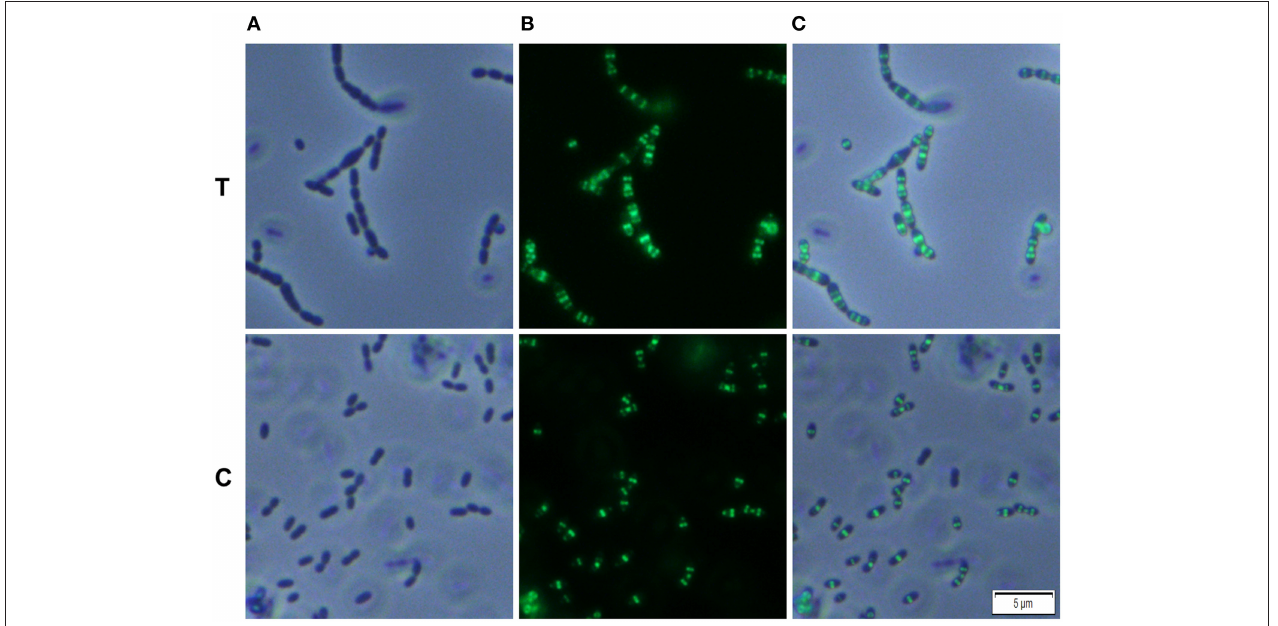
FIGURE 3 | Effect of Carolacton treatment on the localization of the cell division protein DivIVa in S. mutans UA159. The chromosomal GFP + -DivIVa reporter strain MR39 was grown in buffered (75 mM and pH 6.5) complex THBY medium to the early exponential growth phase (OD 600 = 0.2). Cells were treated with and without 5.3 µ M Carolacton and GFP + -DivIV expression was induced for all samples (treated/untreated) with 1.5% D-xylose. 3 h post induction cells were harvested, washed and analyzed under the fluorescence microscope. Phase contrast (column A ), fluorescence (column B ) and overlay images (column C ) of Carolacton treated (upper panel T ) and untreated control cells (lower panel C ) are presented.